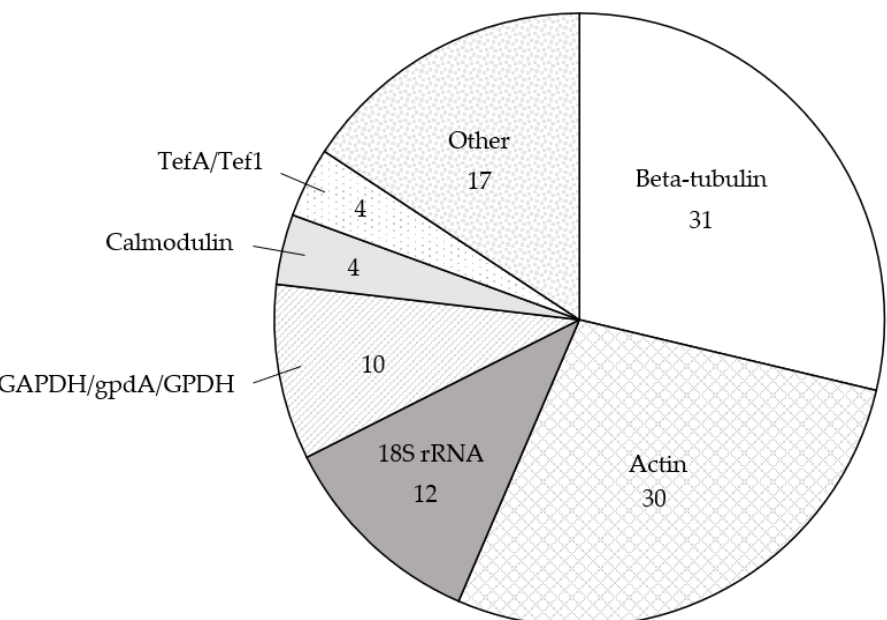
Figure 1. Distribution of reference gene usage across 90 RT-qPCR studies of Aspergillus . Note that in the 90 studies examined, reference genes were used a total of 108 times, as some studies used multiple reference genes. Therefore, 108 was used as the denominator when computing the frequency of reference gene usage. The group “other” is comprised of reference genes that were used fewer than four times. Beta-tubulin was the most frequently used reference genes, at 31 times in the literature.